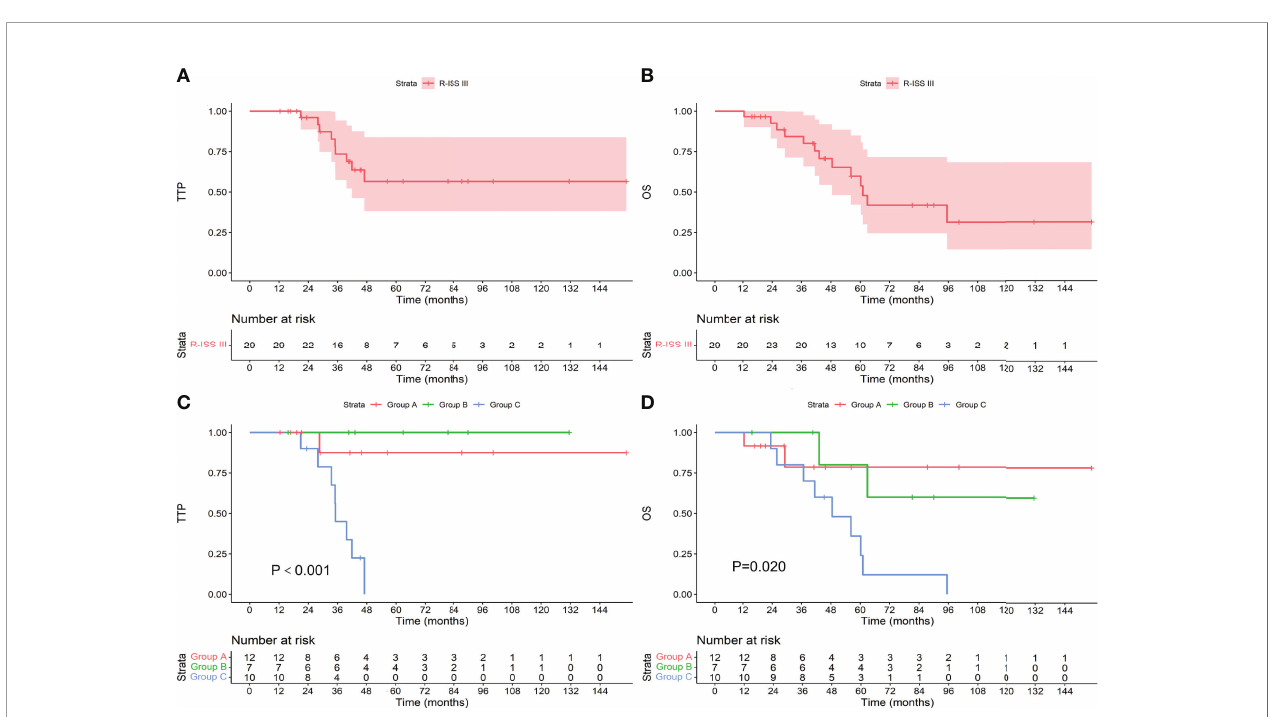
FIGURE 7 | TTP (A) and OS (B) for patients with R-ISS stage III and TTP (C) and OS (D) for patients who achieved an MRD-negative status at different